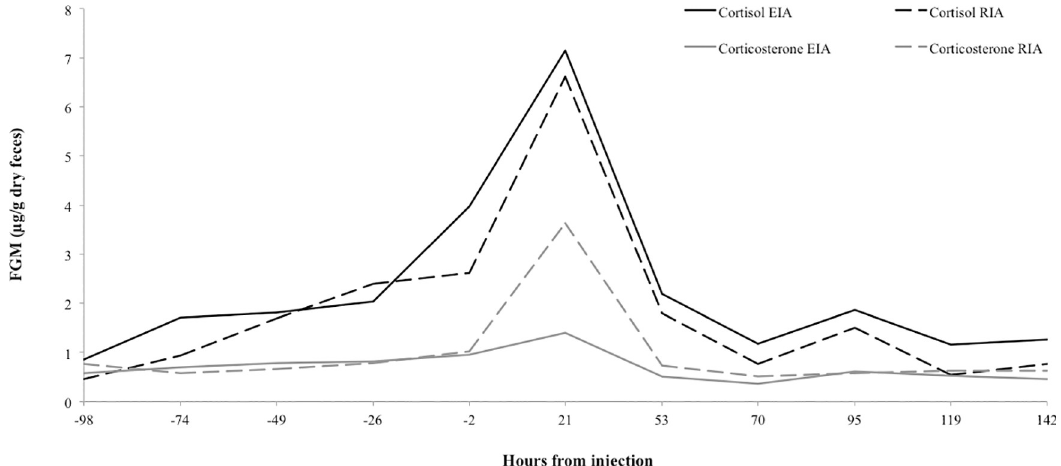
Fig 1. Comparison of four immunoassays employed to characterize fecal glucocorticoid metabolites (FGM) in the feces of a single female fishing cat (SB# 633) during an adrenocorticotrophic challenge. The cortisol RIA (Coat-A-Count, PITKCO-9, 2010-10-21, Siemens, Los Angeles, CA, USA) and corticosterone RIA (I 125 kit ImmuChem, MP Biomedicals, LLC Diagnostics Division Orangeburg, NY, USA) also had measurable peaks above their pretreatment means (not shown here). The corticosterone EIA (R0006 supplied by C.J. Munro) did